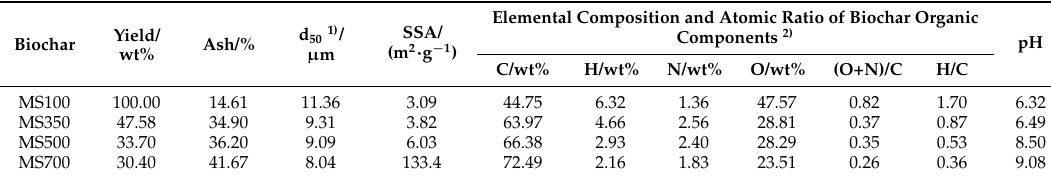
Table 2. The main physicochemical properties of the biochar.